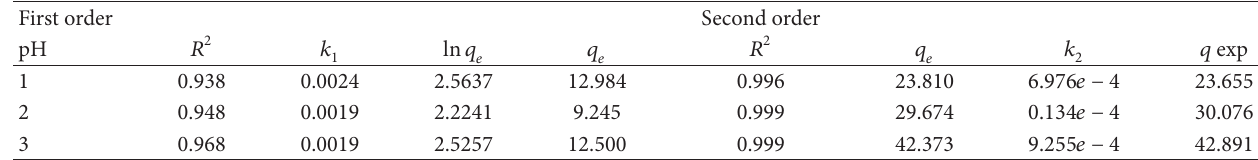
T 4: Comparison of sorption rate constants, experimental, and calculated kinetics of removal for uranium (VI) by